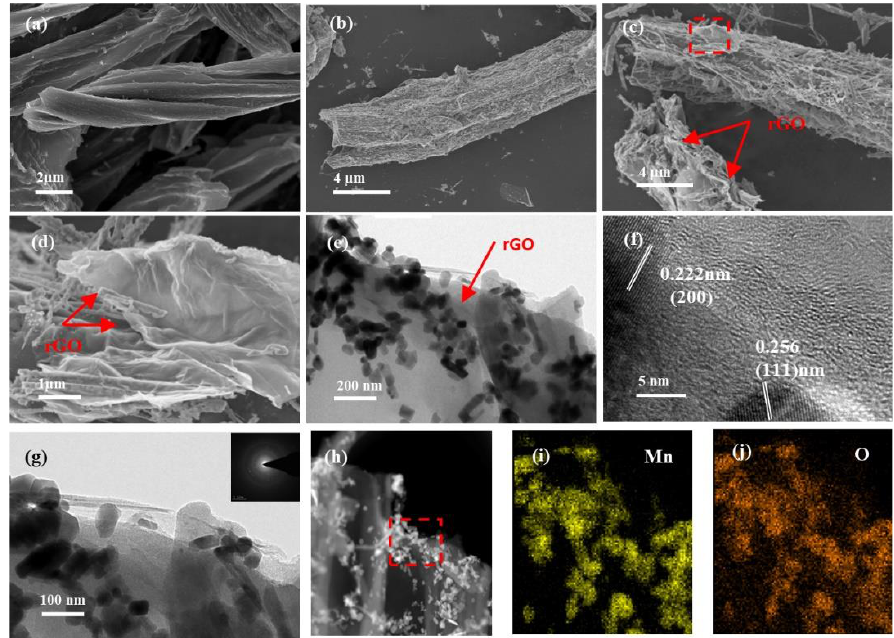
Figure 2. ( a ) SEM of FC, ( b ) SEM of FC@MnO, ( c , d ) SEM of FC@MnO@rGO, ( e ) TEM of FC@MnO@rGO, ( f ) HRTEM of FC@MnO@rGO, ( g ) TEM and SAED (inset in ( g )), ( h ) STEM and corresponding elemental mapping of ( i ) Mn and ( j ) O for